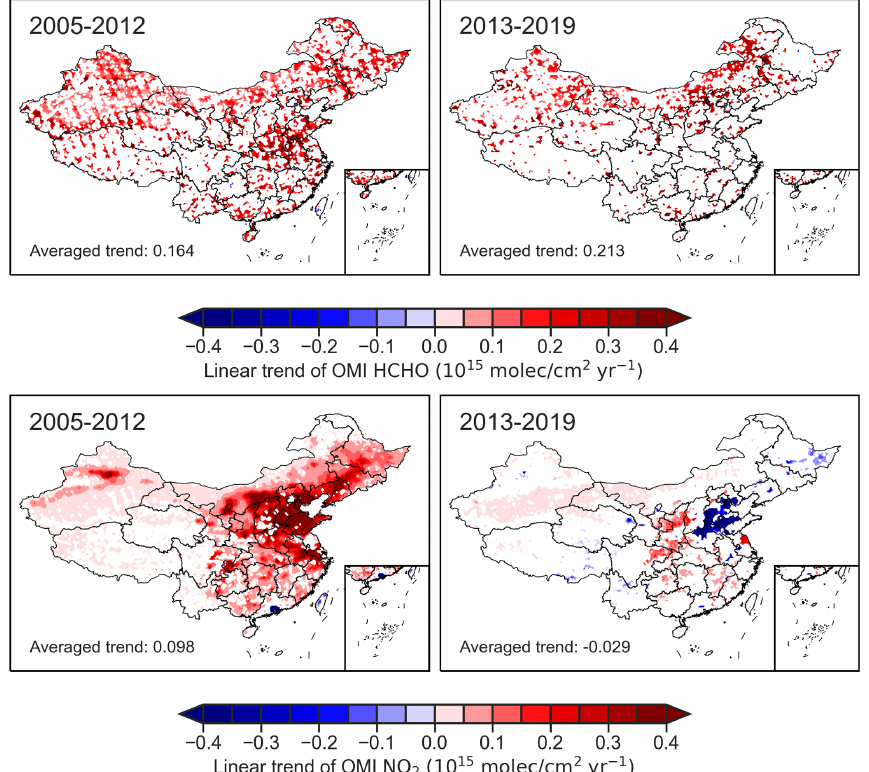
Figure 5. The linear trends of May-to-September HCHO and NO 2 across China during the period of 2005–2012 and